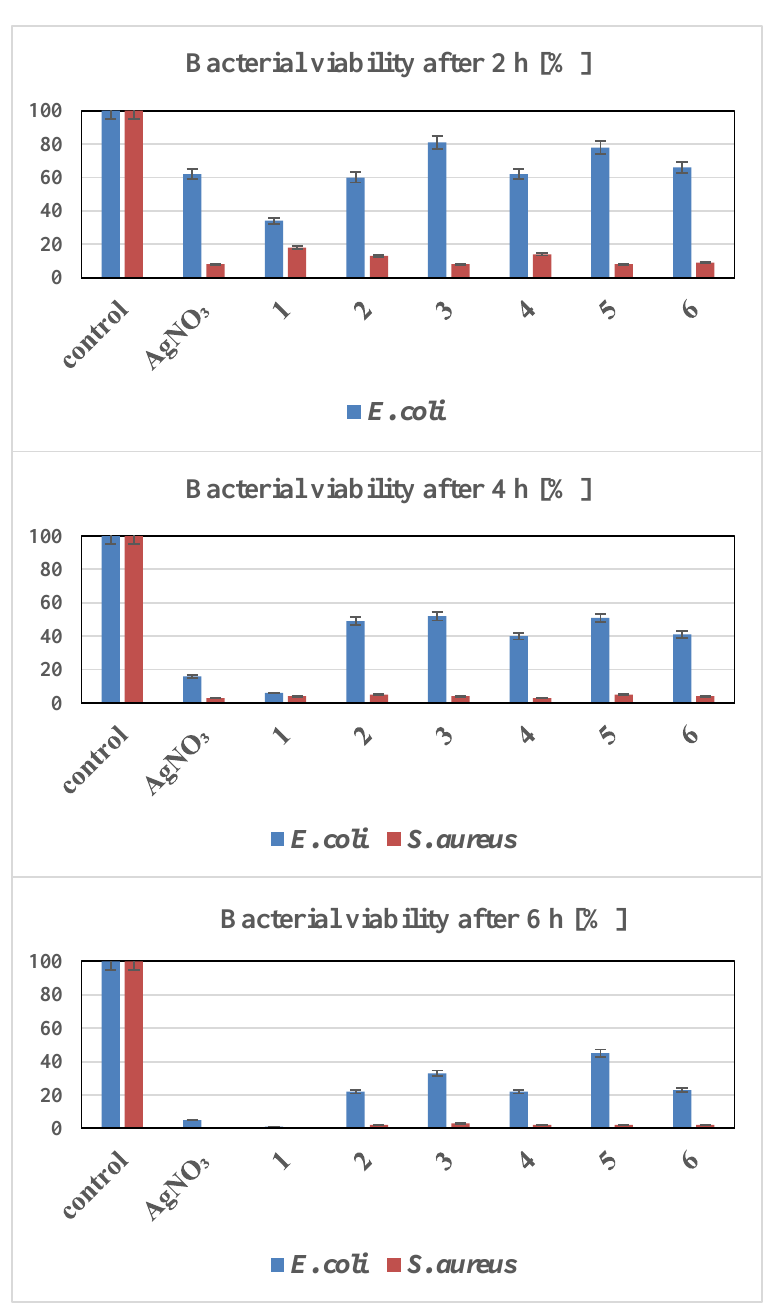
Figure 11. Bacterial viability of S. aureus and E. coli in the presence of silver(I) CPs 1 – 6 and standard AgNO 3 .